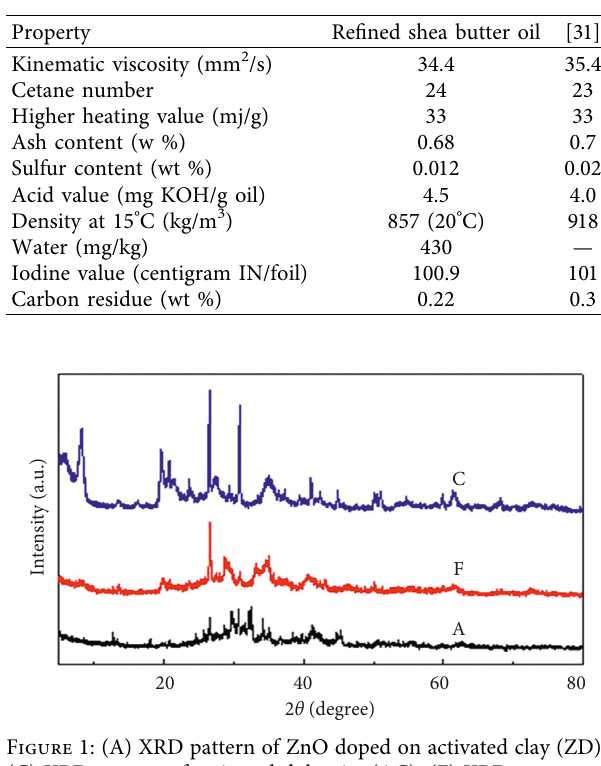
Table 2: Properties of refined shea butter oil in comparison to literature standards.